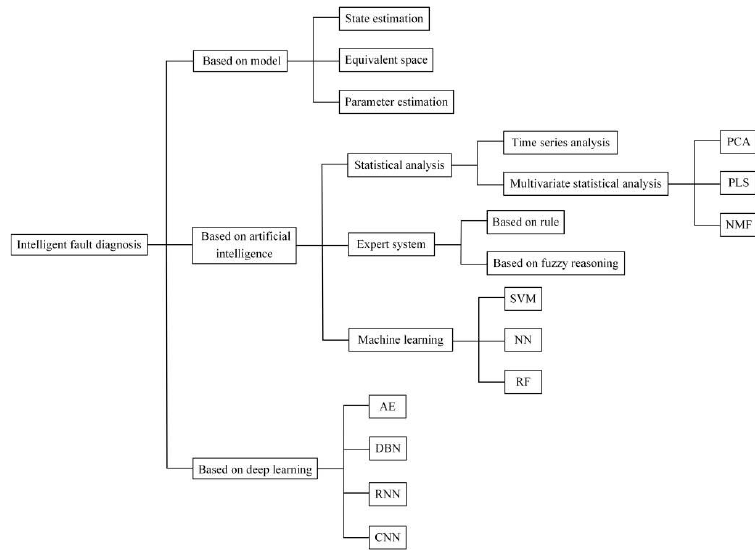
Figure 4. Classification of intelligent fault diagnosis